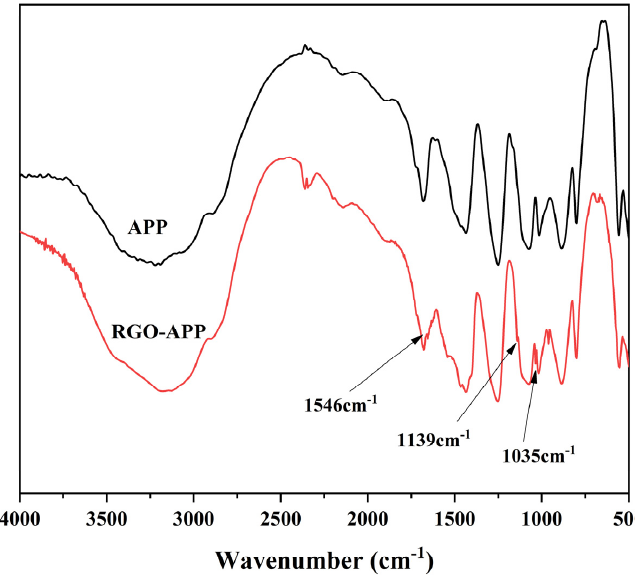
Figure 2. FTIR of APP and RGO-APP.